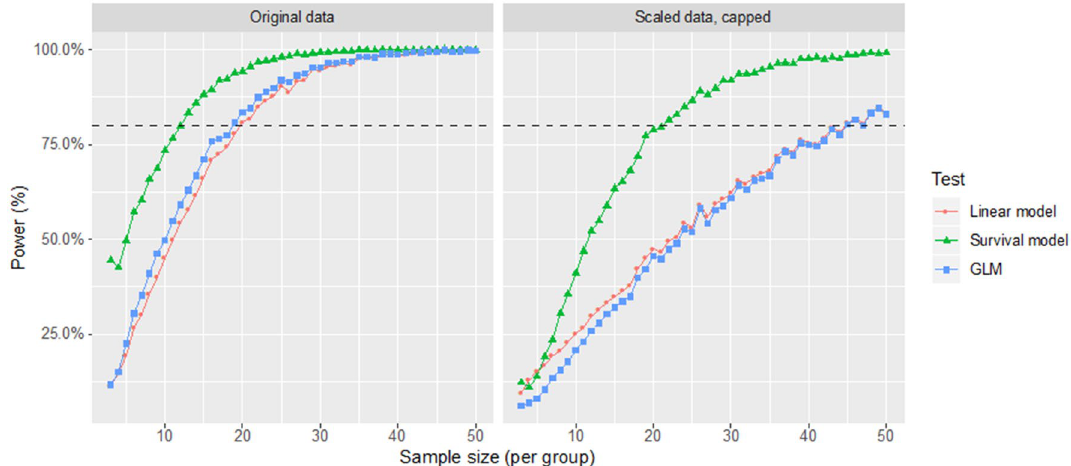
Figure 2. Power curves as a function of sample size for the three methods considered with and without capping for the scaled data. The power curves for the original data (not scaled) are identical to the scaled uncapped data and are therefore not reported (10,000 bootstrap simulations for each step in the sample size). Figure generated using the ggplot2 package 32 .